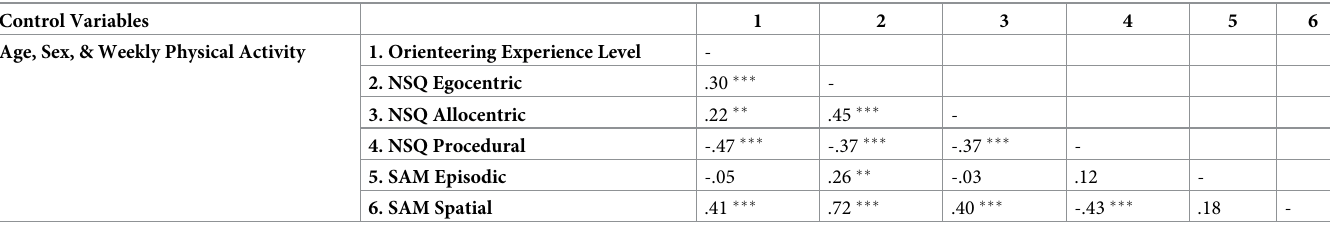
NSQ, Navigational Strategy Questionnaire; SAM, Survey of Autobiographical Memory. �� reflects p < .01, ��� reflects p <